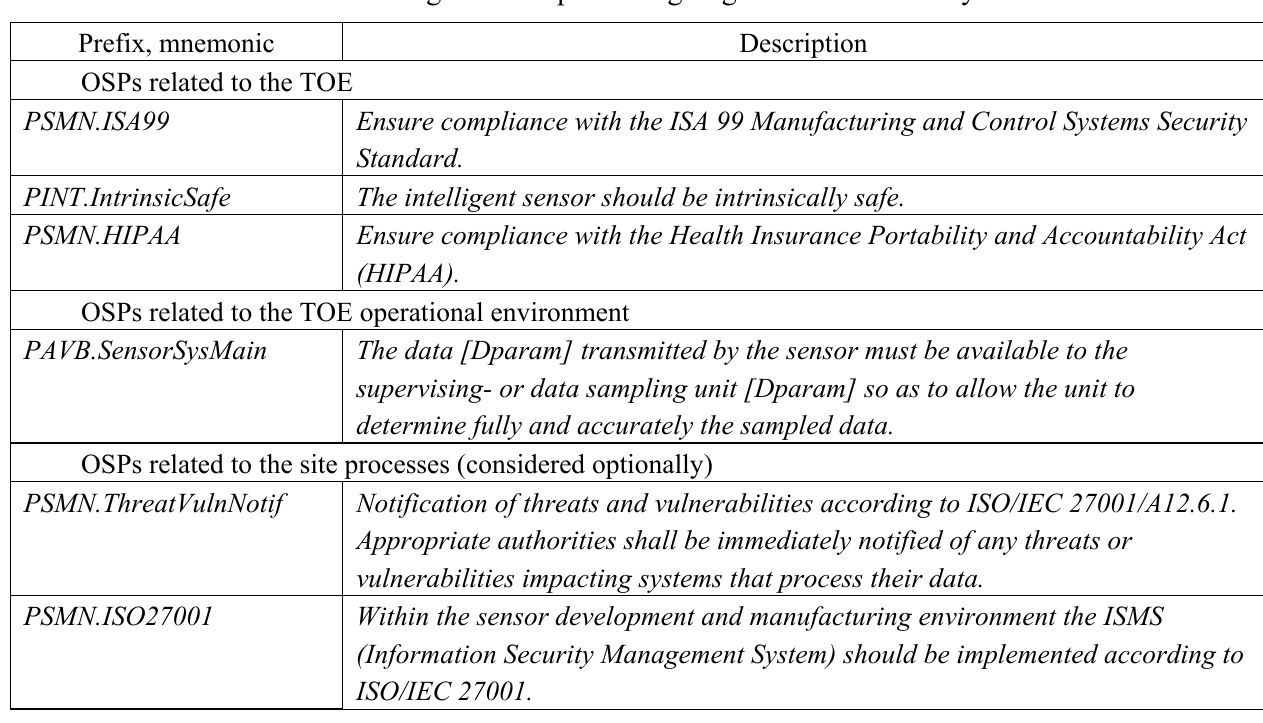
Table 13. Enhanced generics representing Organizational Security